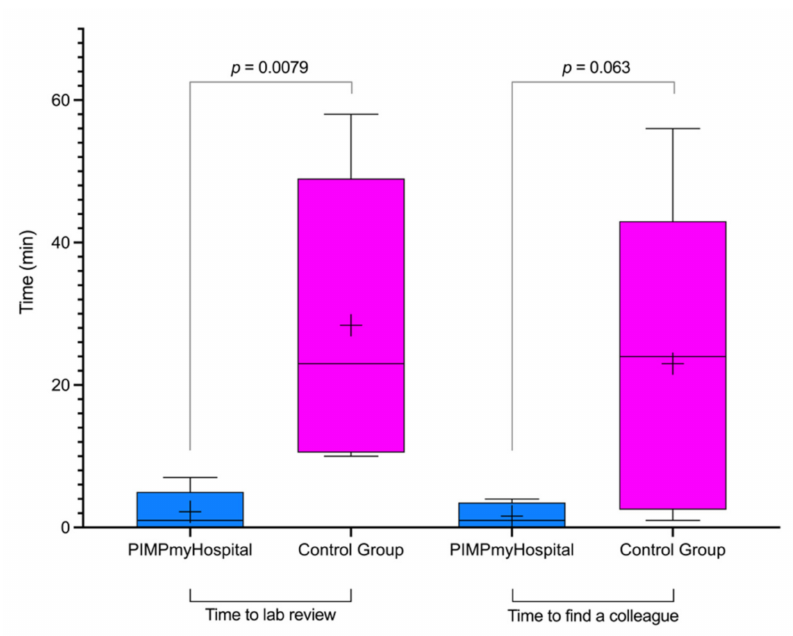
Figure 3. Boxplots of time to laboratory review and time to find a colleague when using the mobile app compared to conventional methods. Solid horizontal lines denote median and IQR; the endpoints of the whiskers indicate the range. The long upper whiskers show that participants were more varied among the most positive quartile groups. The cross denotes the